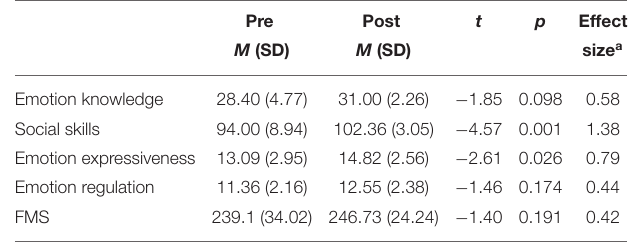
TABLE 4 | Single instructor ratings of session enjoyment and feasibility. Session no.